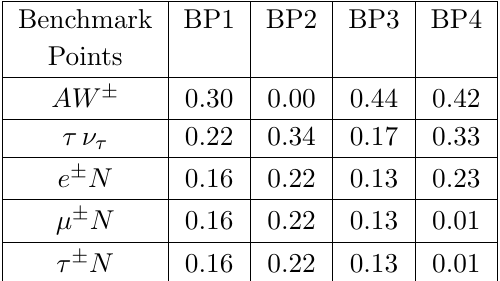
Table 2 . Branching fraction for H (cid:6) for collider study at the LHC for Y N = 0 : 5 ( Y N 0 : 1) for BP1 - BP3 (BP4). Here N corresponds to inclusive of heavy neutrinos, i.e., P